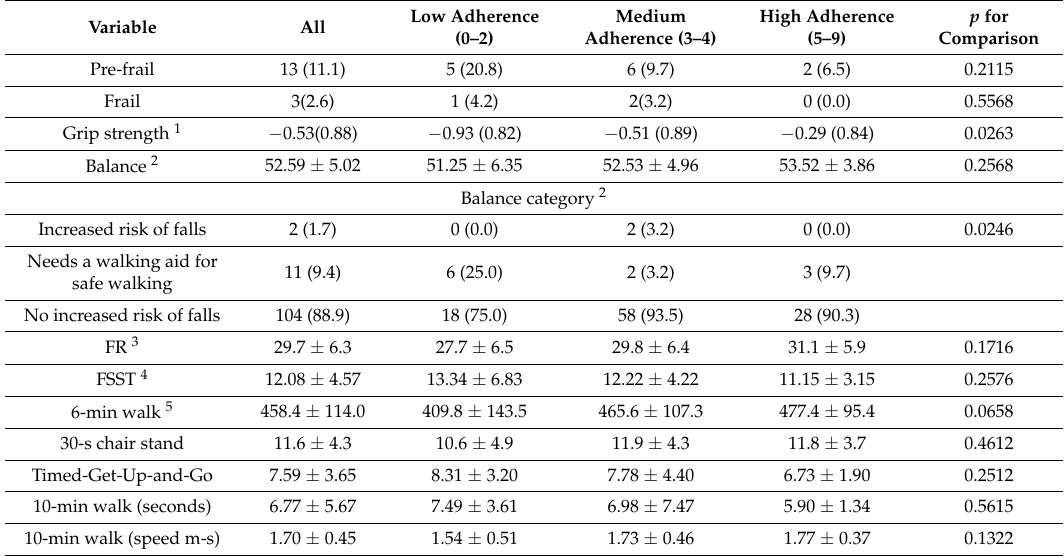
Table 2. Physical and aerobic strength and balance according to adherence to the Mediterranean Diet